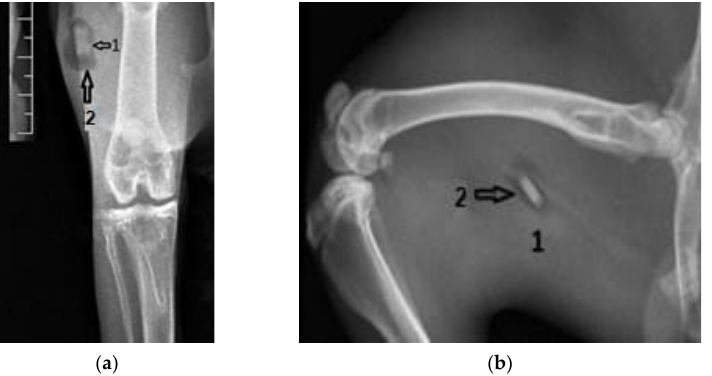
Figure 10. Group two, six weeks after surgery. 1- The partially resorbed Mg–1Ca alloy, 2-Hydrogen bubbles around the implant site: ( a ) Coronal view; ( b ) Lateral view.